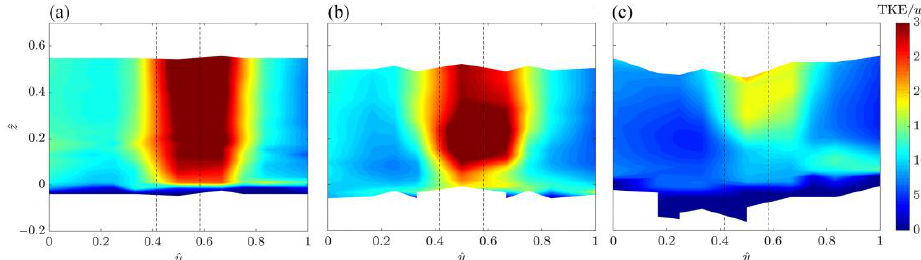
Figure 10. Contours of the dimensionless TKE in the downstream plane section (from LV to RV) for ( a ) Run 1, ( b ) Run 2 and ( c ) Run 3. The black dashed lines show the cylinder position. Analogously to the upstream flow field, from the normal shear stress distributions shown in Figure 11, it is possible to evaluate the contributions of the TKE patterns. Spe-